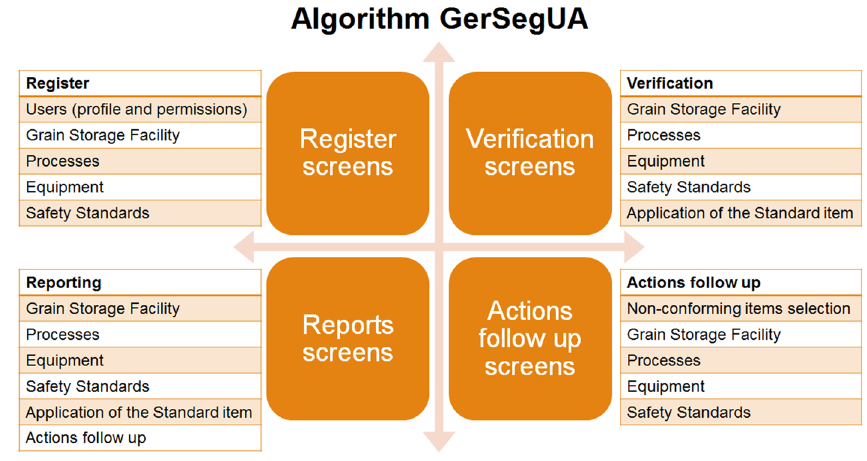
Figure 4. Algorithm development screens set.